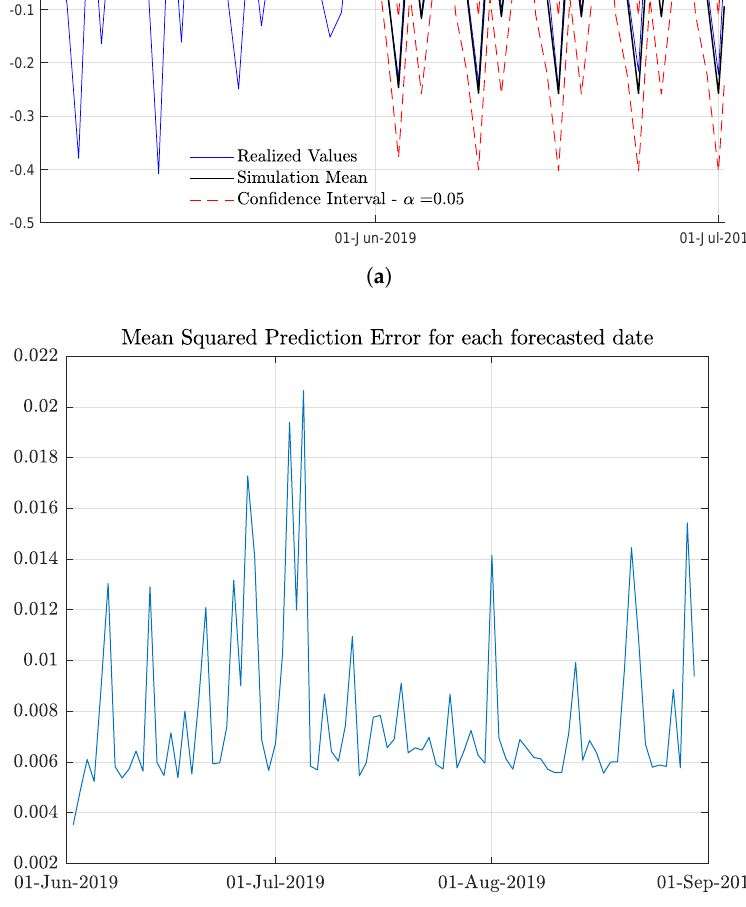
( s ) be the forecasted t + j